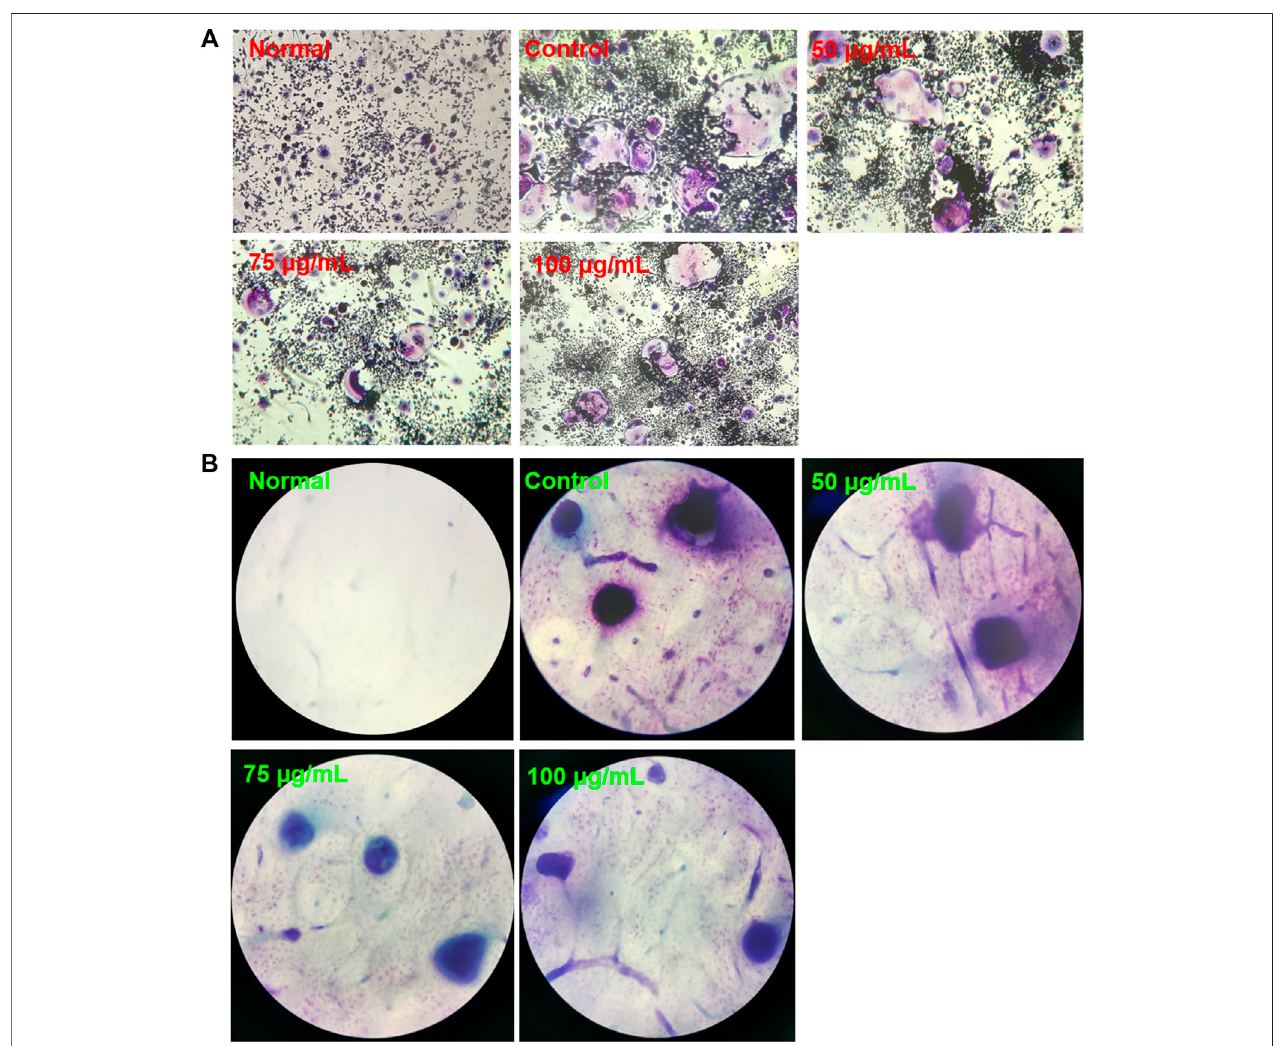
FIGURE 6 | Osteoclastogenesis with TRAP staining (A) and bone resorption assay (B) .